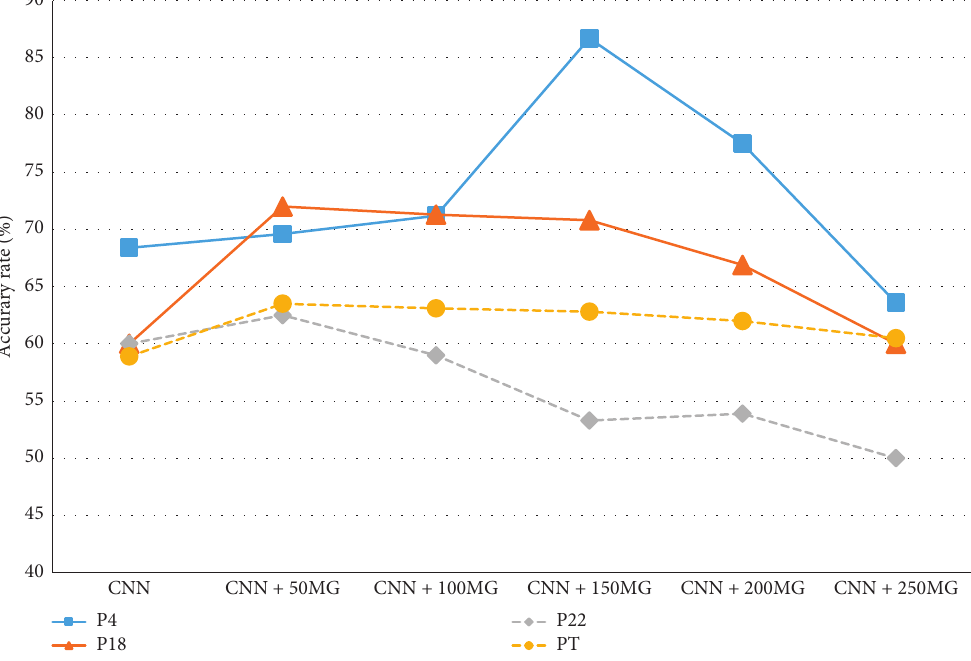
Figure 11: Comparison of accuracy rate achieved by the proposed method with different n Table 1: Accuracy of chromosome classification in dataset with different parameters, i.e., n p .